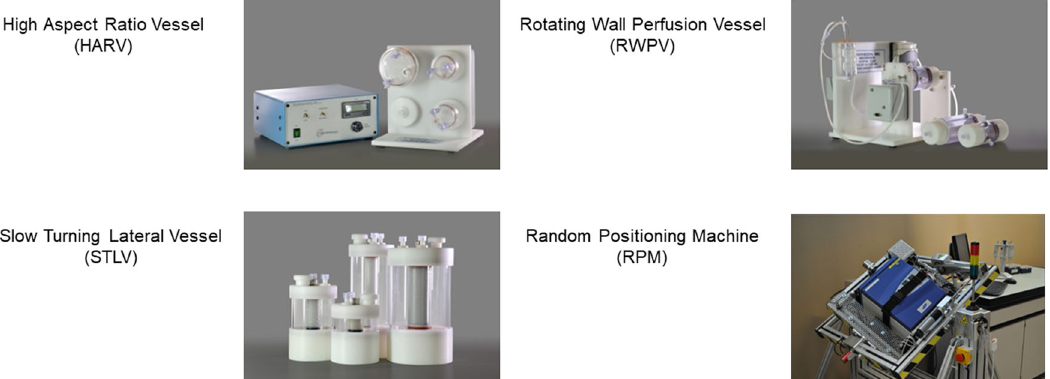
Fig. 1 Ground-based systems for simulating microgravity. HARV, STLV, and RWPV images from Synthecon, Houston, TX with permission from Bill Anderson. RPM image reprinted from Wuest et al. 139 with no modi fi cation under the CC BY 3.0 License (https://creativecommons.org/